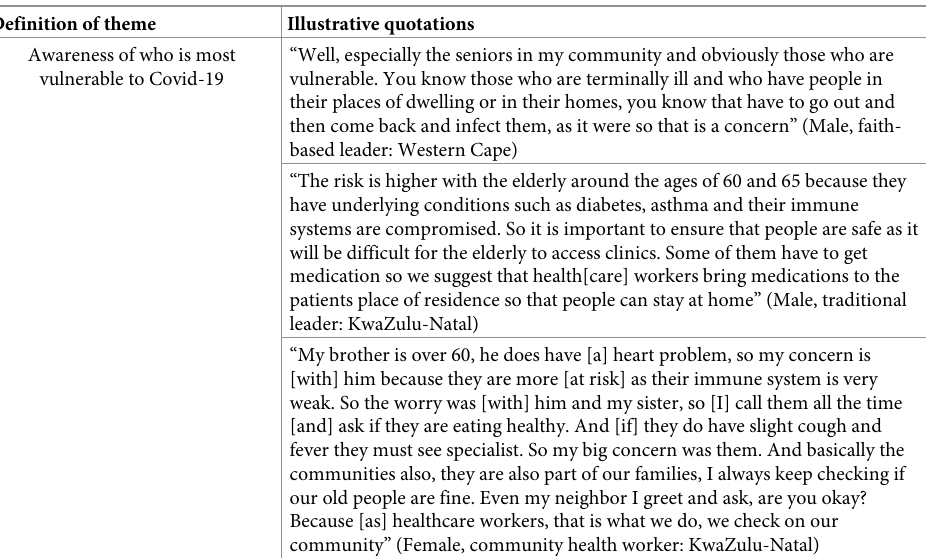
Table 2. Awareness of who is most vulnerable to